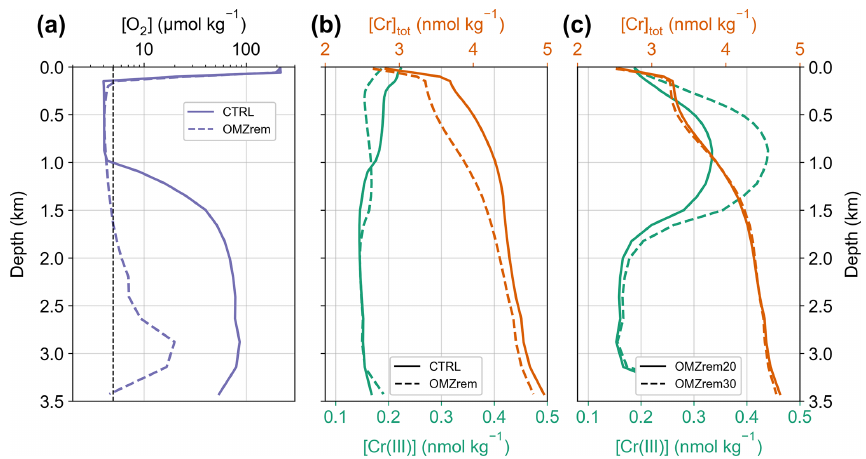
Figure 7. Eastern equatorial Pacific (7.5 ◦ N, 90 ◦ W) (a) oxygen concentration for CTRL (i.e., globally uniform POM remineralization) and the O 2 -dependent remineralization as described by Battaglia et al. (2018) used for the sensitivity experiments. (b) Total Cr and Cr(III) concentrations for CTRL and simulation OMZrem. (c) Same as (b) but for simulations OMZrem20 and OMZrem30.